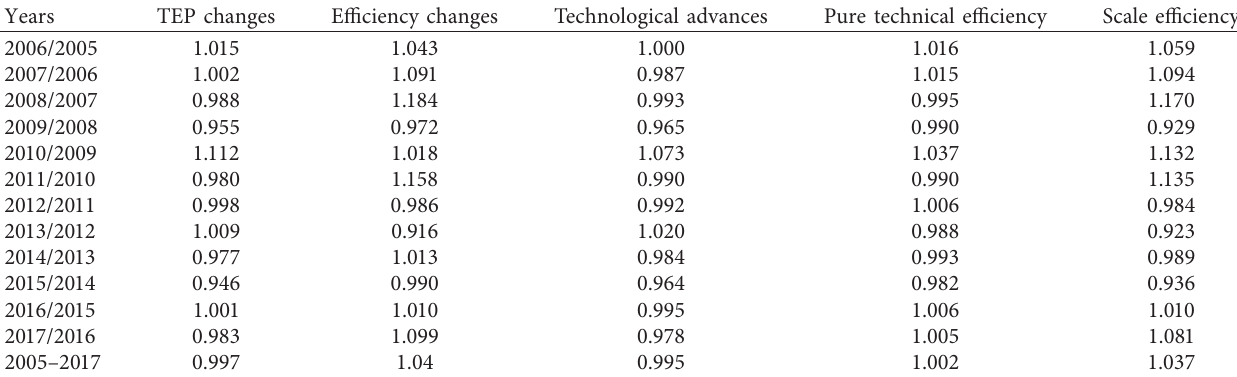
Table 1: Industrial TFP index and its decomposition index from 2005 to